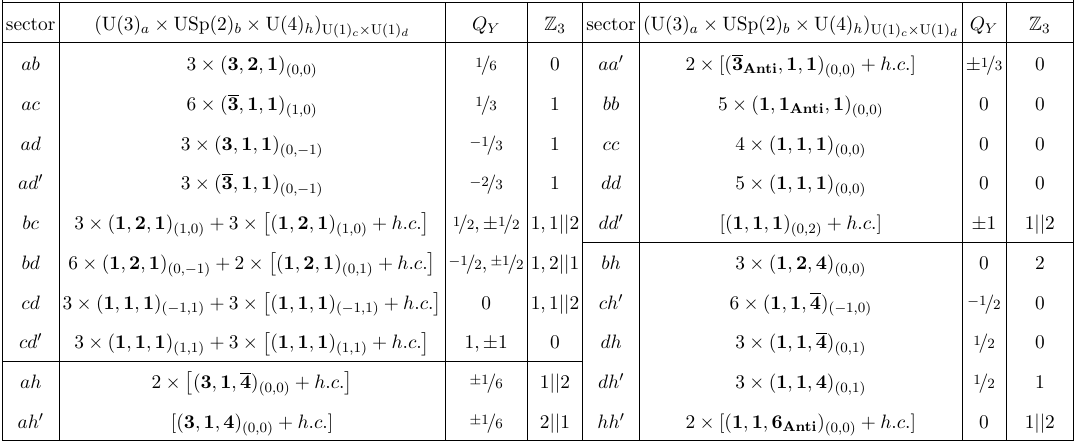
Overview of the massless matter spectrum of a global 5-stack MSSM on the aAA lattice of T 6 = ( Z 2 (cid:2) Z 6 (cid:2) (cid:10) R )